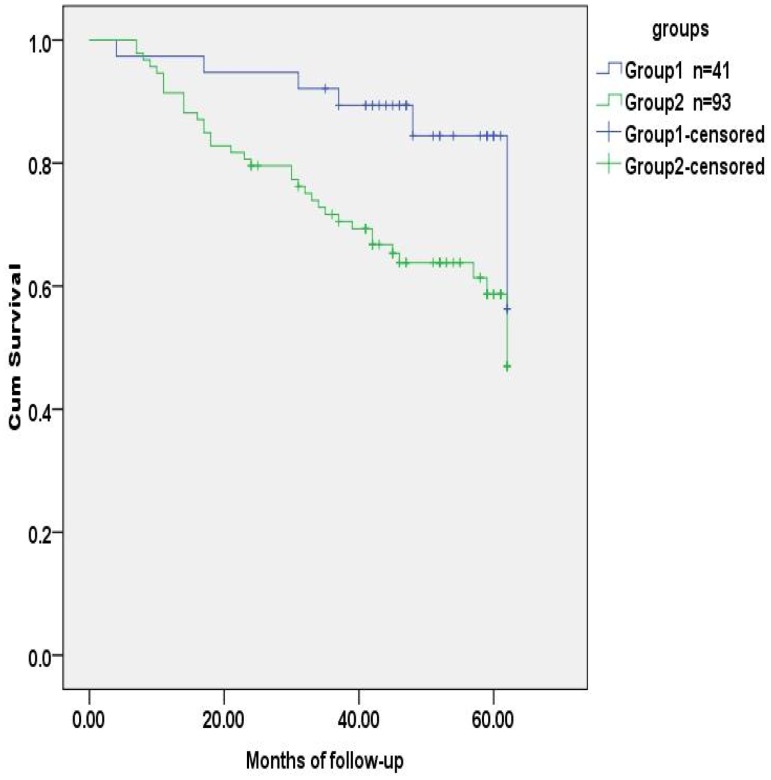
Tumor-free survival analysis of CRC patients stratified by rs1047781+rs8176746 genotypes.Subjects were divided into 2 groups by genetic maker (rs1047781+rs8176746). Group 1 was rs1047781 (AA) +rs8176746 (AA+AG) and group 2 was rs1047781 (AT+TT) +rs8176746 (AA+AG). The disease-free time of subgroups was significantly different (p = 0.023).